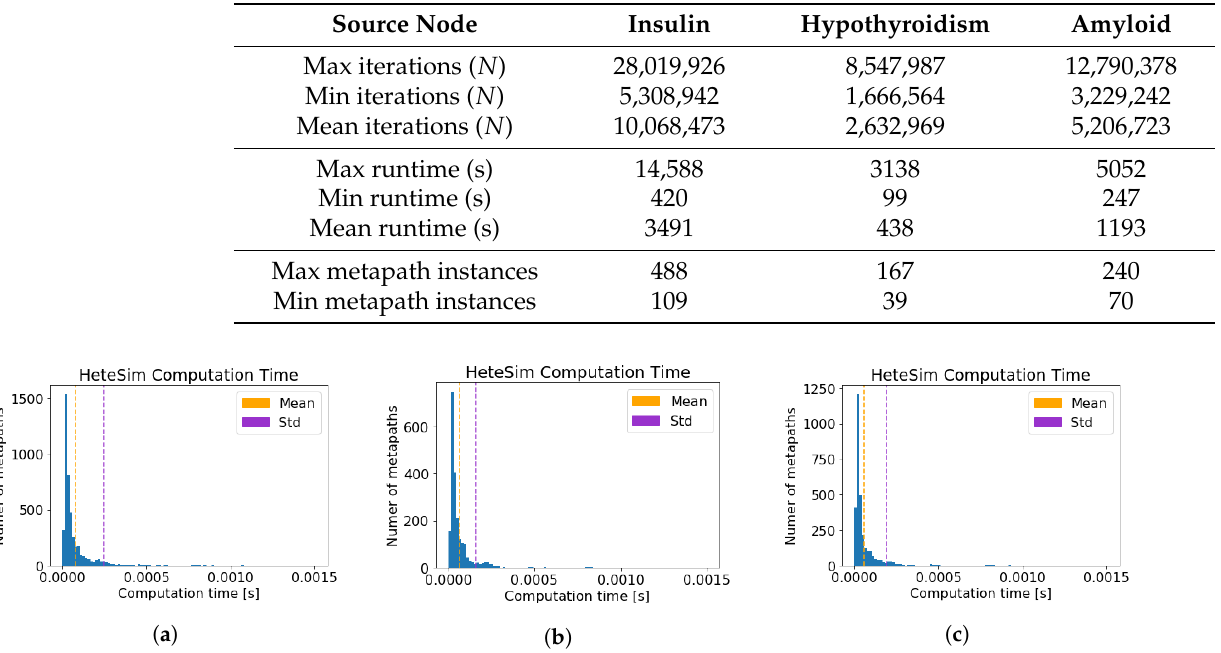
Figure 9. HeteSim computation times per metapath for all metapaths of length 2 from the given source node to Alzheimer’s disease, using the deterministic HeteSim implementation from SemNet version 2. ( a ) Insulin; ( b ) Hypothyroidism; ( c ) Amyloid. As a final timing comparison, the top 20 length 4 metapaths (again determined by the metapaths comprised of the highest number of unique paths) were generated for each of the three testing target-source node pairs, and the deterministic HeteSim algorithm was run on all 60 metapaths. The 20 length 4 metapaths were taken out of a subset of the first 100,000 to- tal length 4 metapaths shared between each respective source node and AD. Metapath computation is the greatest bottleneck, and retrieving any more than 100,000 metapaths per source node is simply too time consuming as of right now. The maximum, minimum, and mean runtimes for this final test are shown in Table 6. As a final side note, different runs of both SemNet versions 1 and 2 might vary in computational time due to changes in concurrent computational load and random, extrinsic factors. This slight variation does not change the ultimate goal or conclusion of this